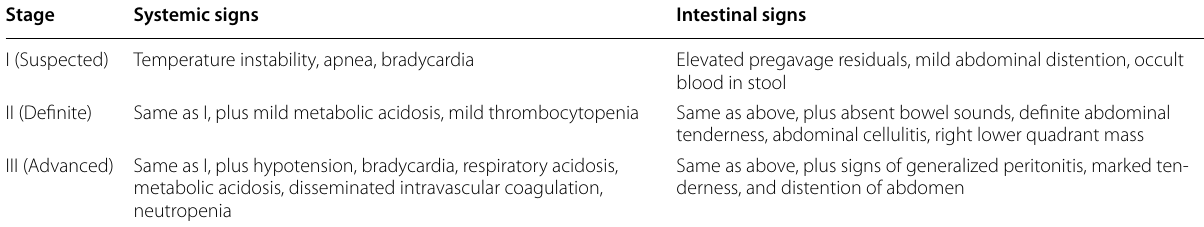
Table 1 Modified Bell’s staging criteria for NEC Stage Systemic signs Intestinal